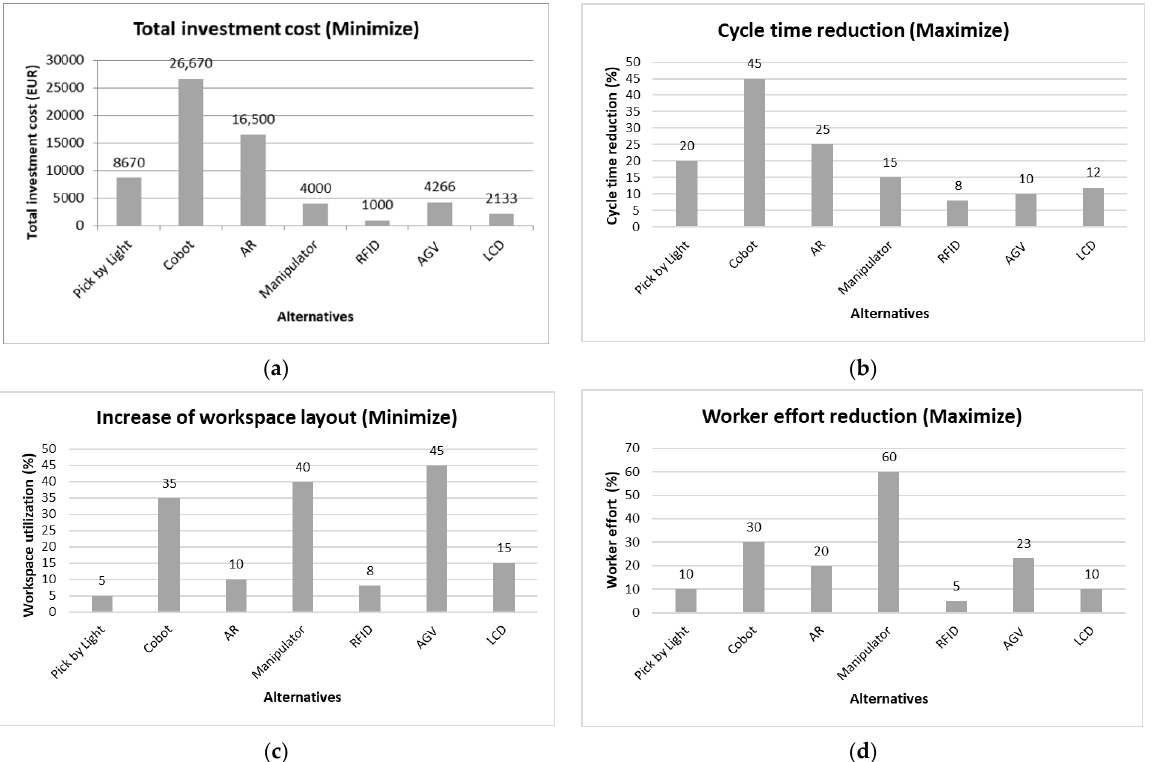
Figure 5. Criteria evaluation for each alternative: ( a ) total investment cost; ( b ) cycle time reduction; ( c ) worker effort reduction; ( d ) increase of workspace layout.